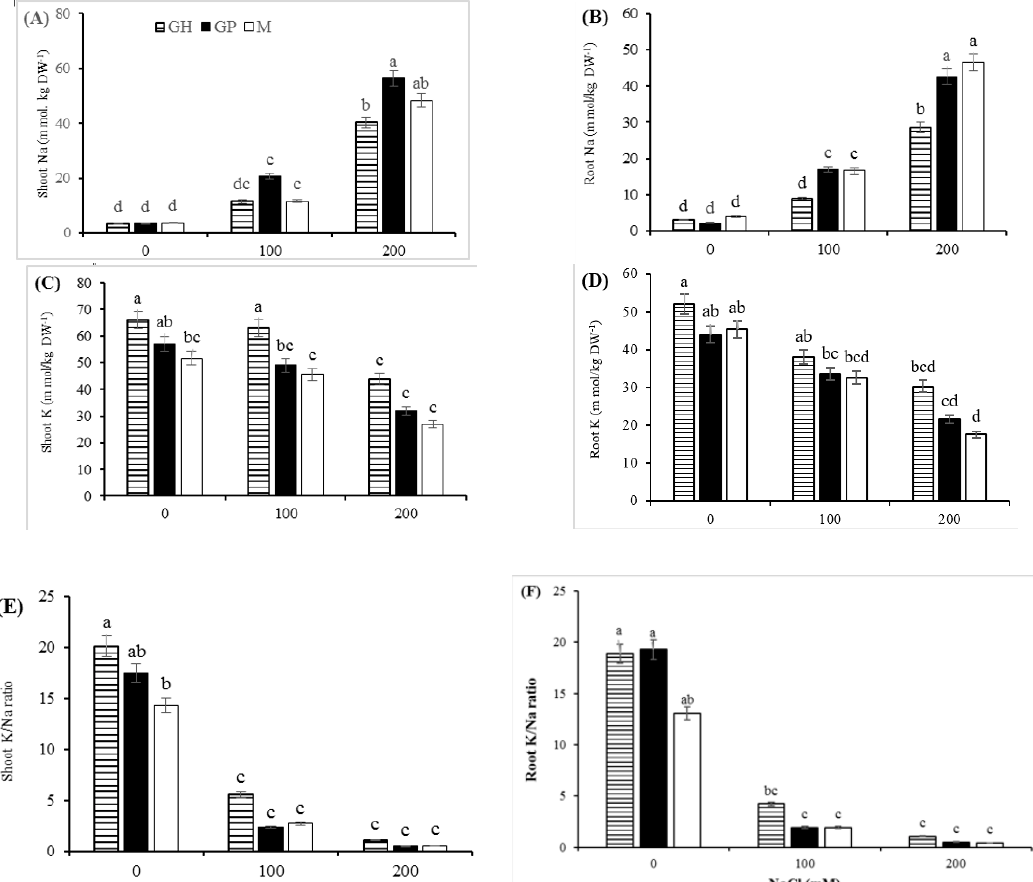
Figure 4. Effect of salinity on Na + ( A , B ) and K + distribution ( C , D ) and K + /Na + ratio ( E , F ) in shoot and root organs of three pistachio rootstocks including GH (Ghazvini), GP (Ghermez-Pesteh) and M ( P . atlantica subsp . mutica ). Means followed by the same letter are not significantly different according to Tukey’s multiple range test ( p < 0.05). The salinity stress treatments sharply reduced the K + content in shoots and roots of the rootstocks. A dramatic decrease in K + /Na + ratio was observed in the shoots and roots by increasing the salinity level. The K + content and K + /Na + ratio of the most salt-tolerant rootstock (GH) was always higher than that in the other rootstocks, regardless of the in- tensity of salt stress (Figure 4C–F). There was a positive correlation between the K + content of shoots and growth parameters such as stem height, leaf number and plant leaf area (Figure 5).